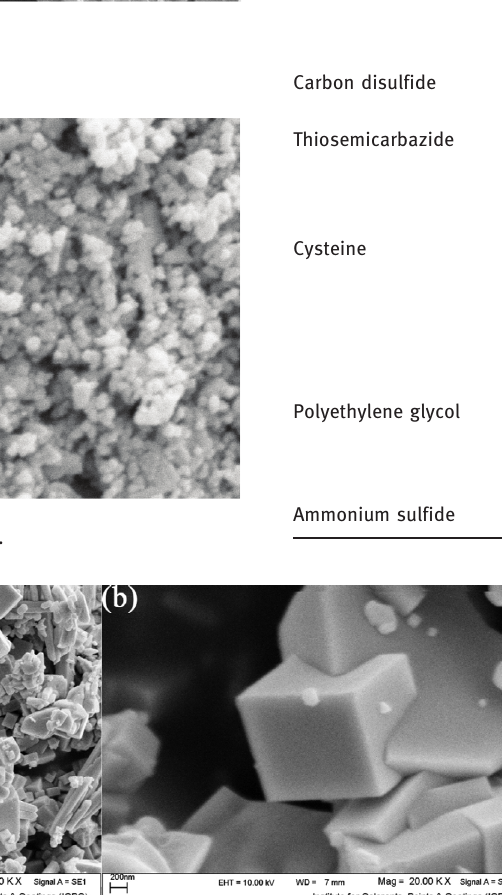
Figure 10 (a, b): SEM image of sample no. 2 with 4 KX and 20 KX magnification, respectively.